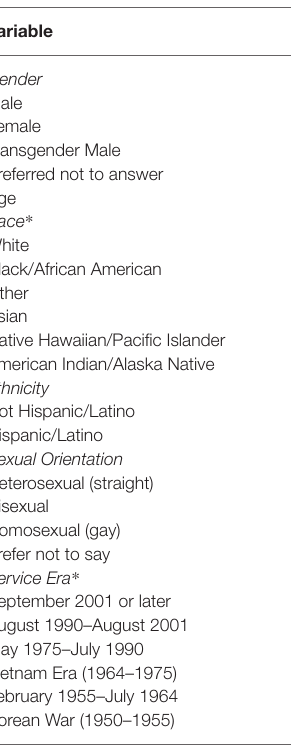
TABLE 1 | Sample demographics ( N =